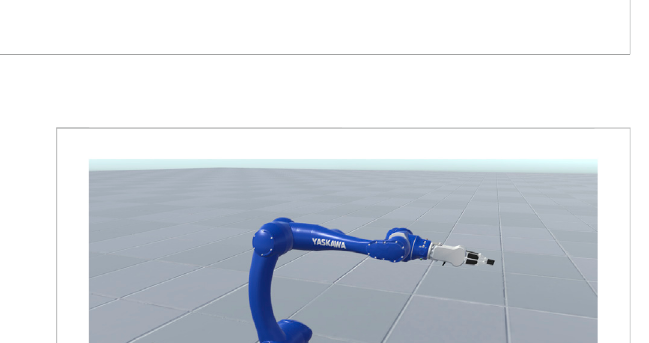
FIGURE 1 Virtual reality robot operating system structure.